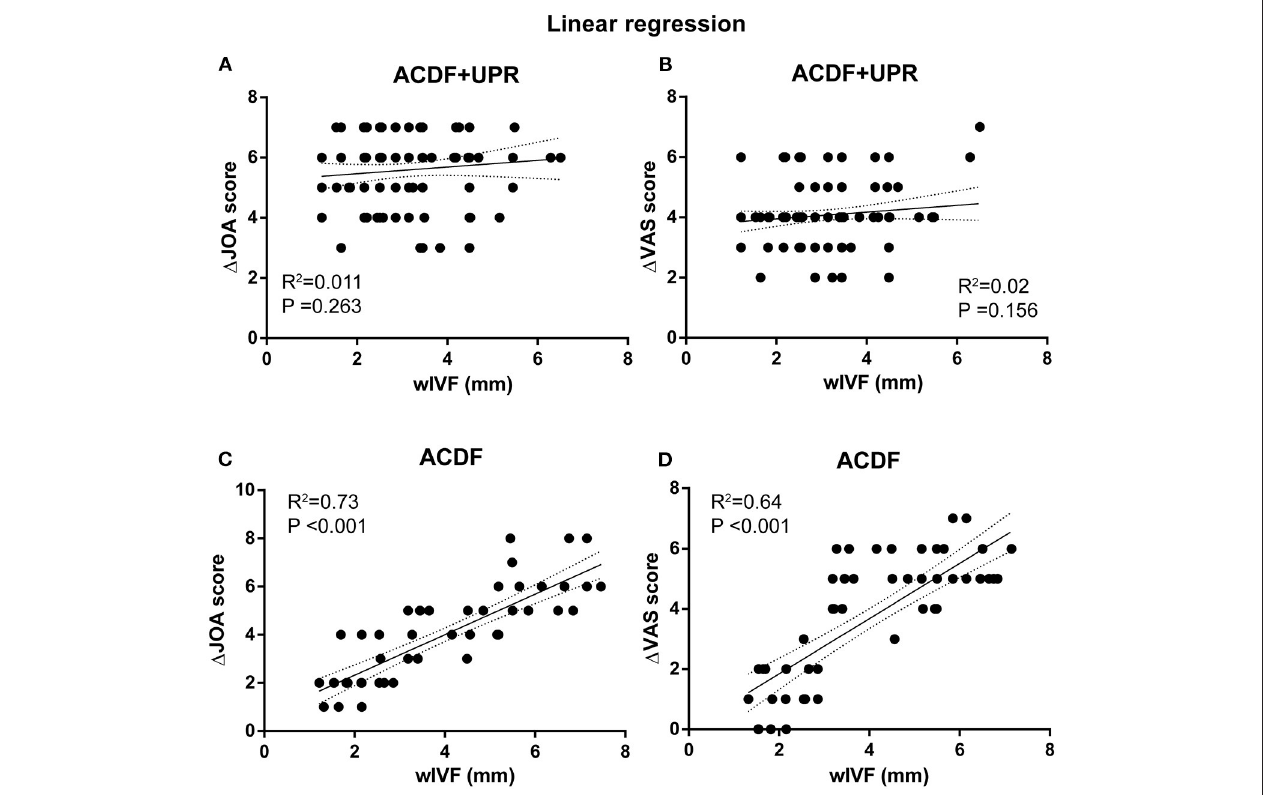
FIGURE 3 | Linear regression plots of VAS and JOA score in ACDF + UPR or ACDF alone. Linear regression analysis of VAS and JOA score in ACDF + UPR or ACDF alone patients. Clinical improvement was calculated as (post-operation value)—(pre-operation value) for JOA score ( A,C ) and shown as 1 JOA score; (pre-operation value)—(post-operation value) for VAS ( B,D ) score, and shown as 1 VAS score. P < 0.01 is concerned as significant. While only ACDF groups showed significant correlation of wIVF with clinical improvement ( C,D ).